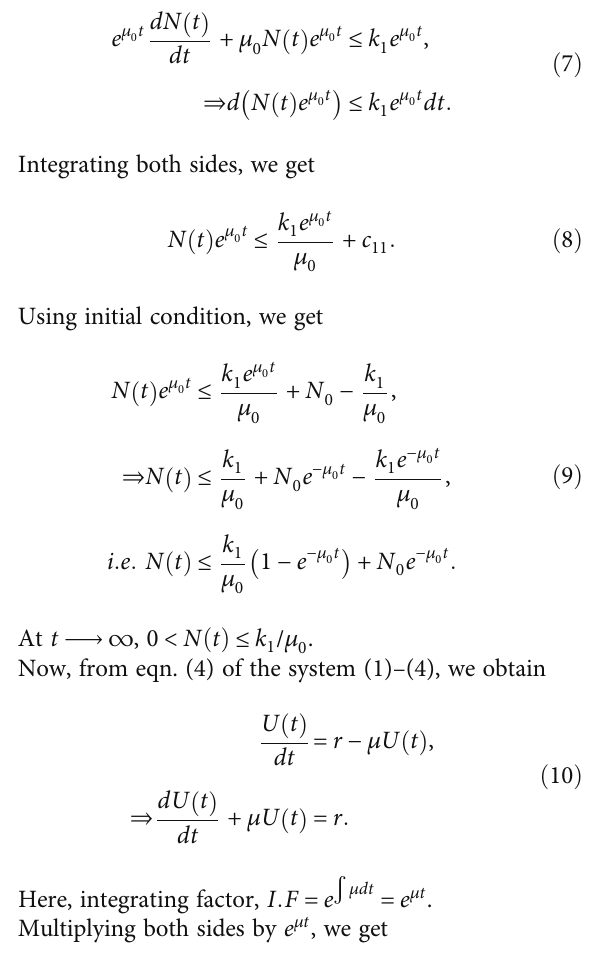
Table 1: Description of model parameters and state variables.